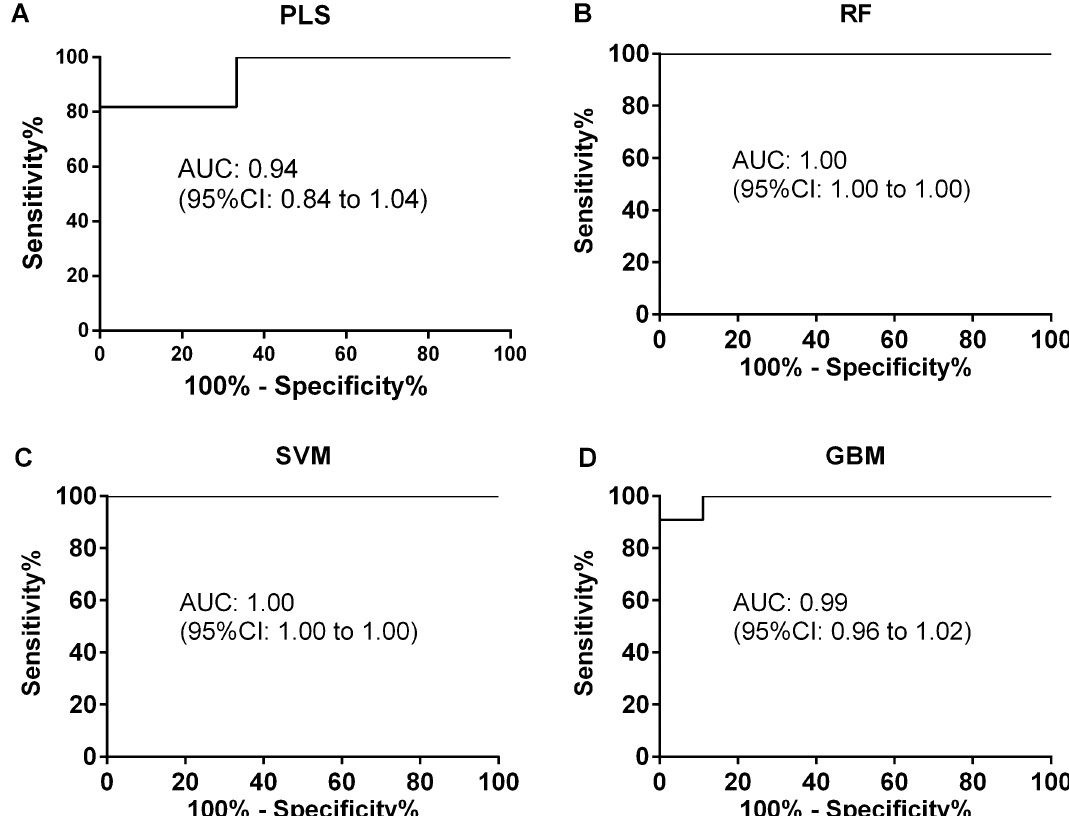
Figure 4. Receiver operating curve (ROC) in predicting pleural effusion classes for the test set. ( A ) Result from PLS model; ( B ) result from RF model; ( C ) result from SVM model; ( D ) result from GBM model.